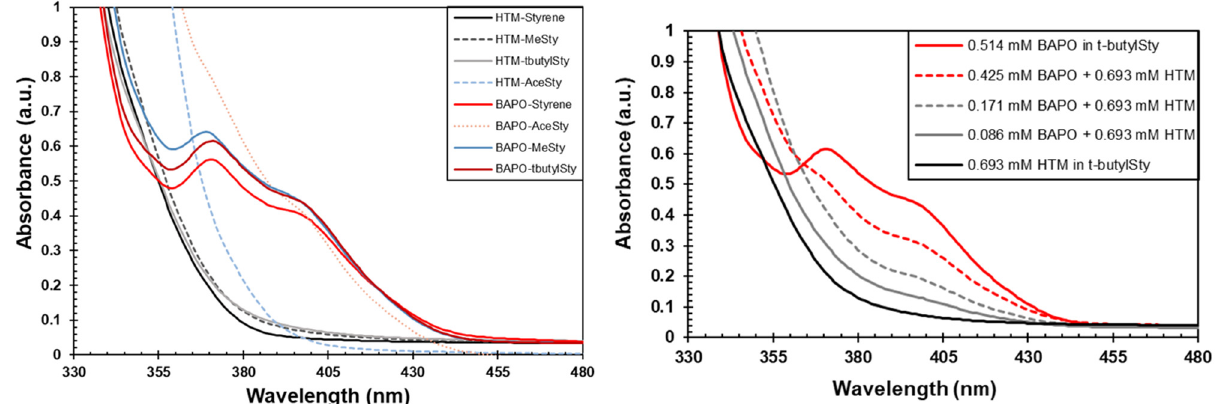
Figure 7. ( Left ) Absorbance of HTM (0.693 mM) and BAPO (0.514 mM) in styrene and its derivatives. ( Right ) Competitive absorbance of HTM (0.693 mM) with increased amounts of BAPO in t-butyl styrene as solvent. Table 1. Absorbance properties and working curve data for HTM:Sty and HTM:Sty d binary formulations. Formulation